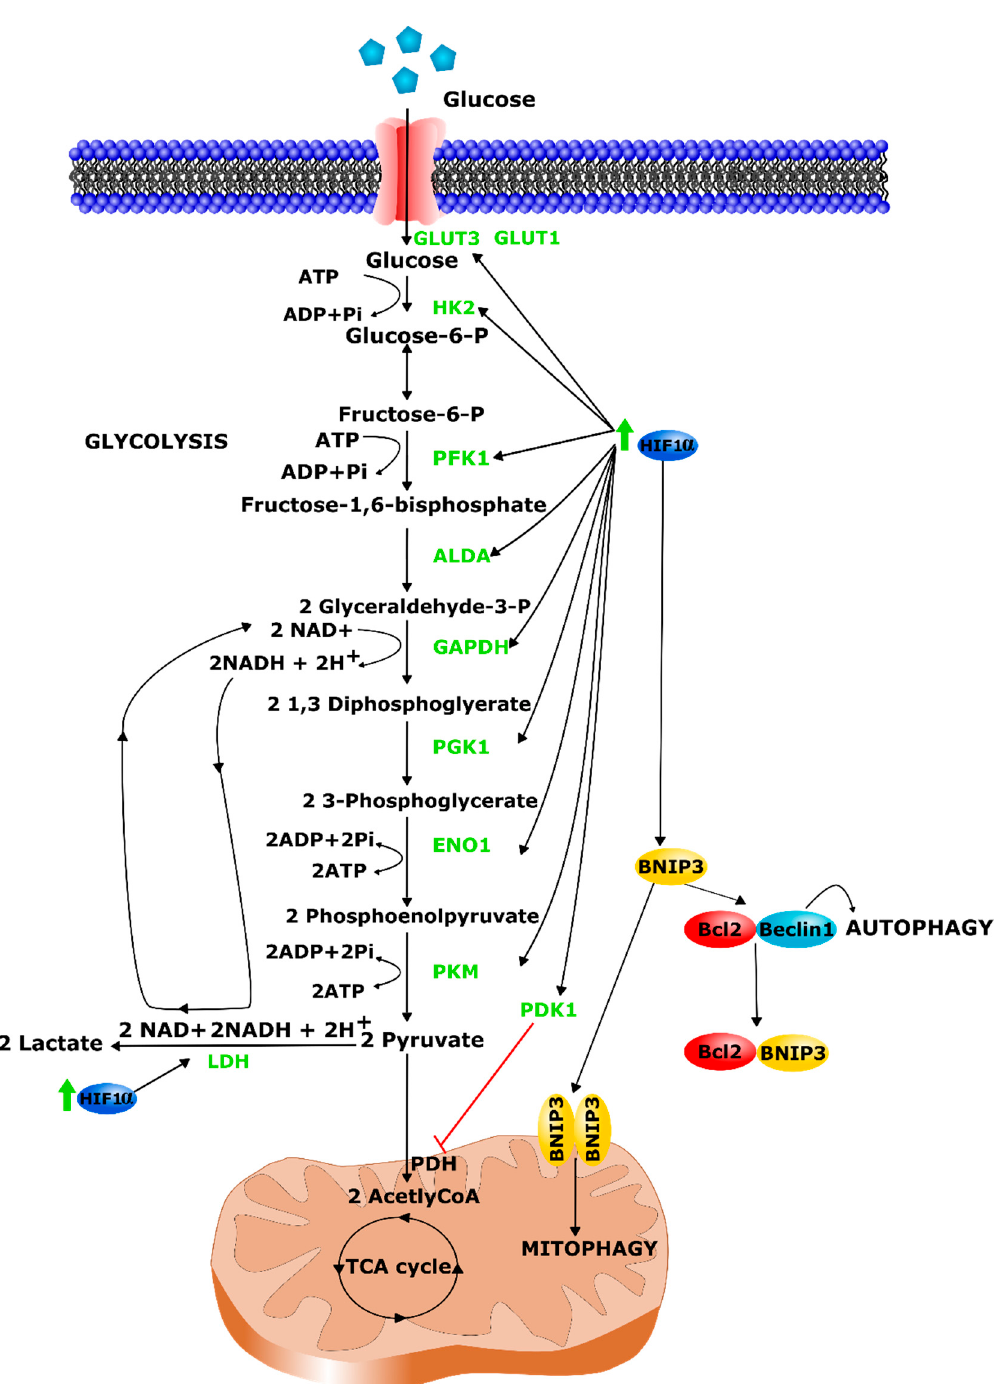
Figure 4. HIF-1 α control on the glycolytic switch and mitophagy. HIF-1 α promotes glycolytic metabolism through the induction of the expression of glycolytic transporters and enzymes (represented in green). Mechanistic aspects of the HIF-1 α -BNIP3 induced mitophagy pathway. Alongside with this metabolic remodeling, hypoxia exposure leads to a decrease of mitochondria content via HIF-1 α -induced mitochondrial autophagy [159]. Autophagy is